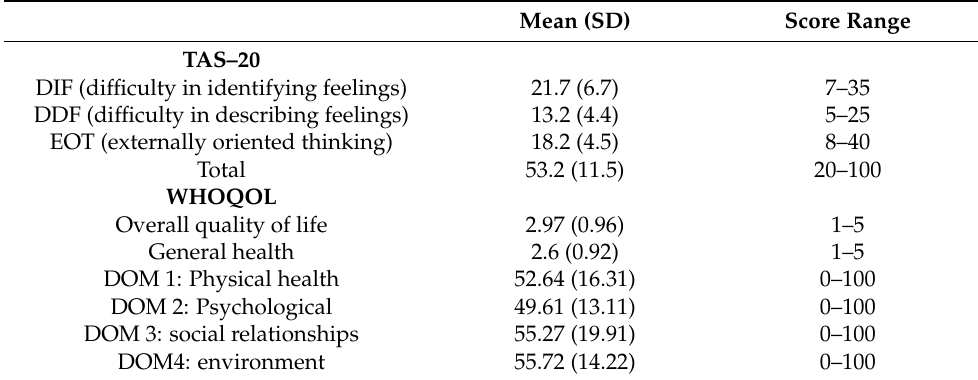
Table 2. Descriptive statistics of the psychological variables of the sample. The mean and standard deviation between parentheses, while in the second column the range are